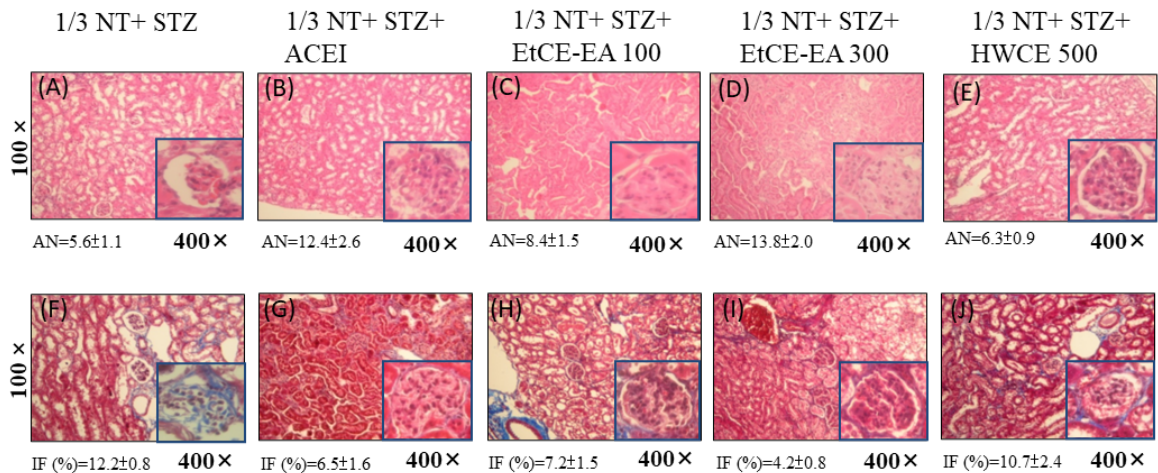
Figure 5. Histopathological study after Inonotus obliquus fruit bodies extracts (IOEs) treatment on the renal cortex in CRF mice. Treatment with ACEI (20 mg/kg), EtCE-EA: Ethyl acetate layer after water-ethyl acetate separation from ethanol crude extract (100 and 300 mg/kg) and HWCE: hot water crude extract of Inonotus obliquus fruit bodies (500 mg/kg) for two consecutive weeks was given in CRF mice with 1/3 NT + STZ-induced diabetic nephropathy, and histopathology of the renal cortex was studied using H&E stain ( A – E ) and Masson’s trichrome stain ( F – J ), respectively in sections of the CRF kidney under magnification 100 × and 400 × . The podocytes of glomerulus in different groups under a light microscope ( × 400). The average number (AN) of foamy podocytes/glomerulus were calculated. The interstitial fibrosis, IF (% positive) were estimated. Data are presented as means ± SEM (n = 5). For each animal (n = 5 for each group), all glomeruli (about 25–30) on another part of a kidney after unilateral nephrectomy sections were counted .